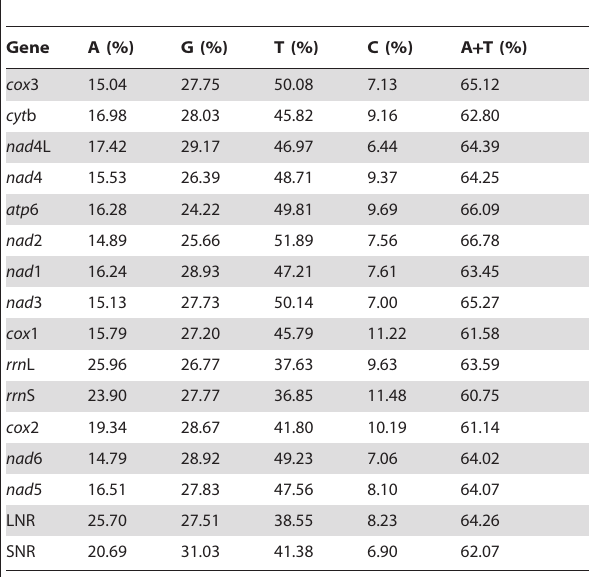
Table 4. Comparisons of A + T content of protein-coding genes and rRNA genes of mt genome of P . cervi .